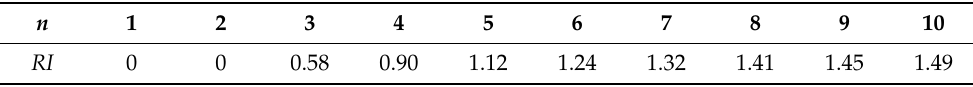
Table 3. Random consistency